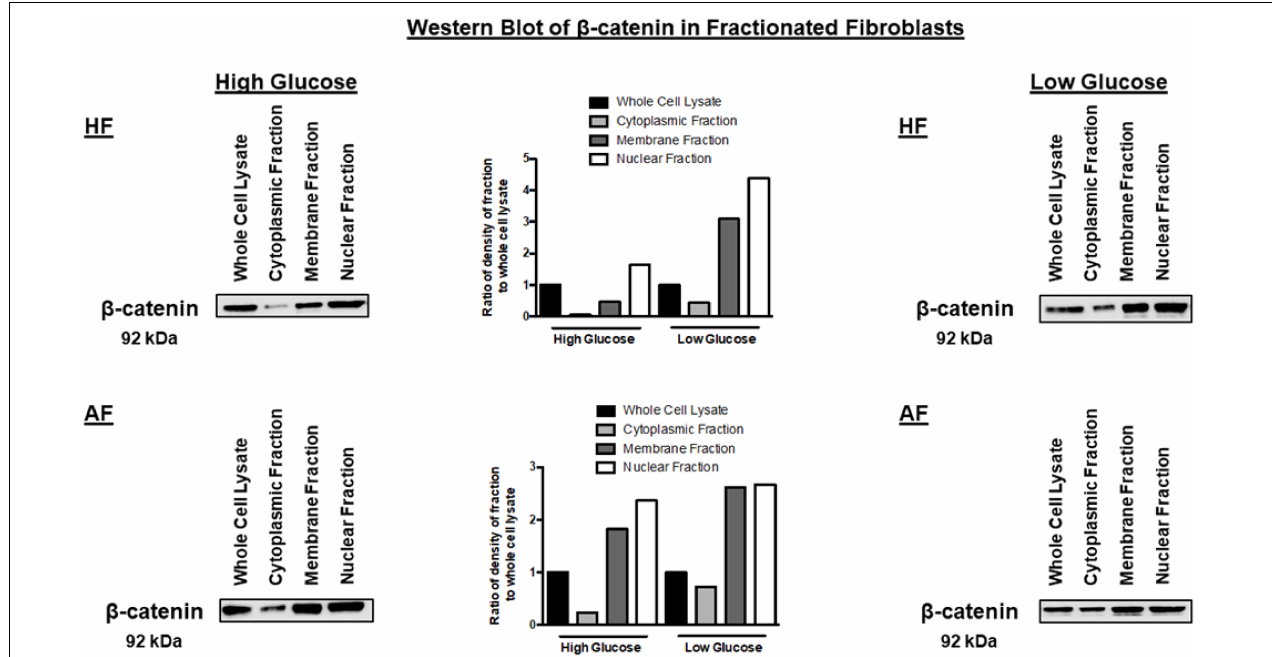
FIGURE 11 | Western blot analysis of cell fractions from healthy bronchial fibroblast (Cell Fractionation Antibody Sampler Kit #11843) showing cytoplasmic, organellular/membrane, and nuclear/cytoskeletal localization. Whole-cell lysates represent total protein. The fractionation was done under two conditions, the cultivation with high-glucose medium and a low-glucose